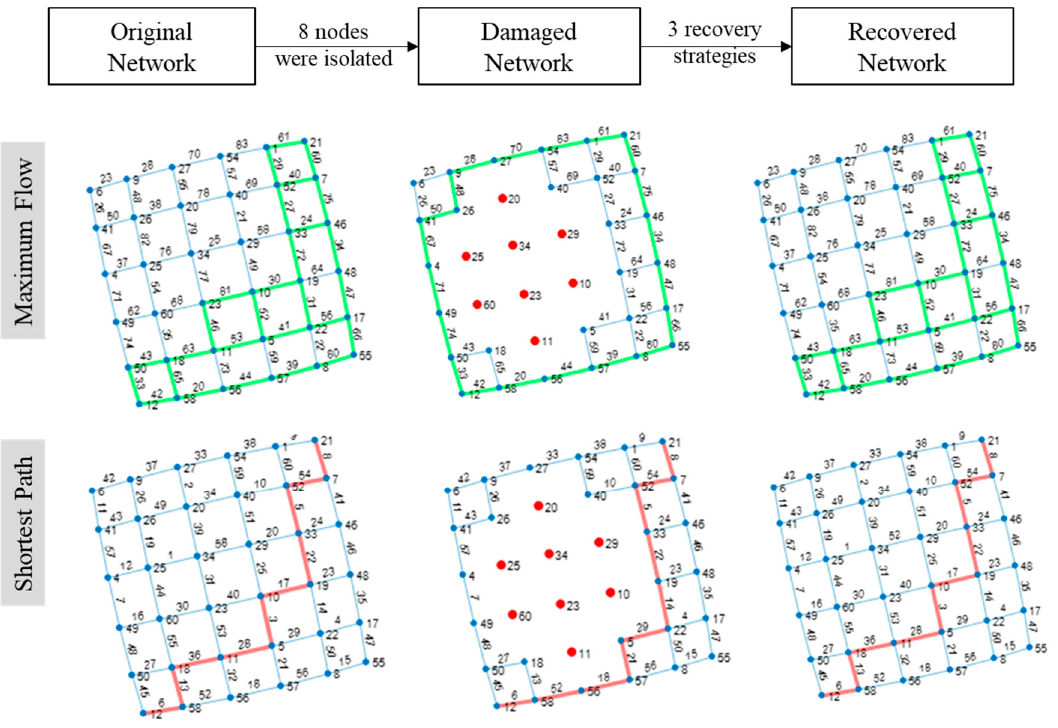
Figure 7. The assessment model in different stages of resilience. Table 2. Degradation propagation from original to degraded